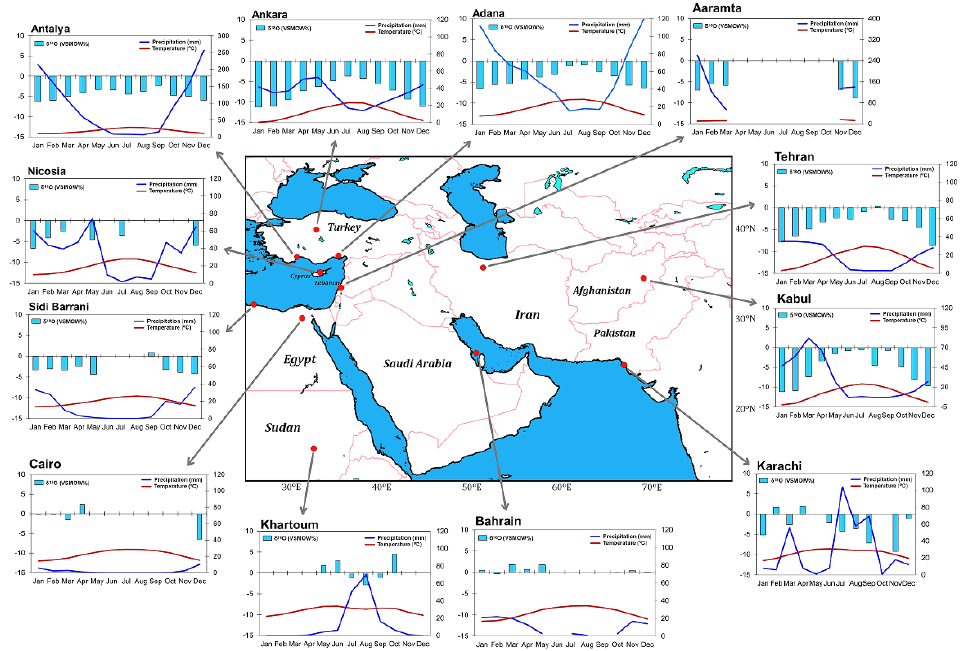
Figure 5. The monthly variations of δ 18 O stable isotopes, precipitation amount, and temperature in twelve stations across the Middle East.